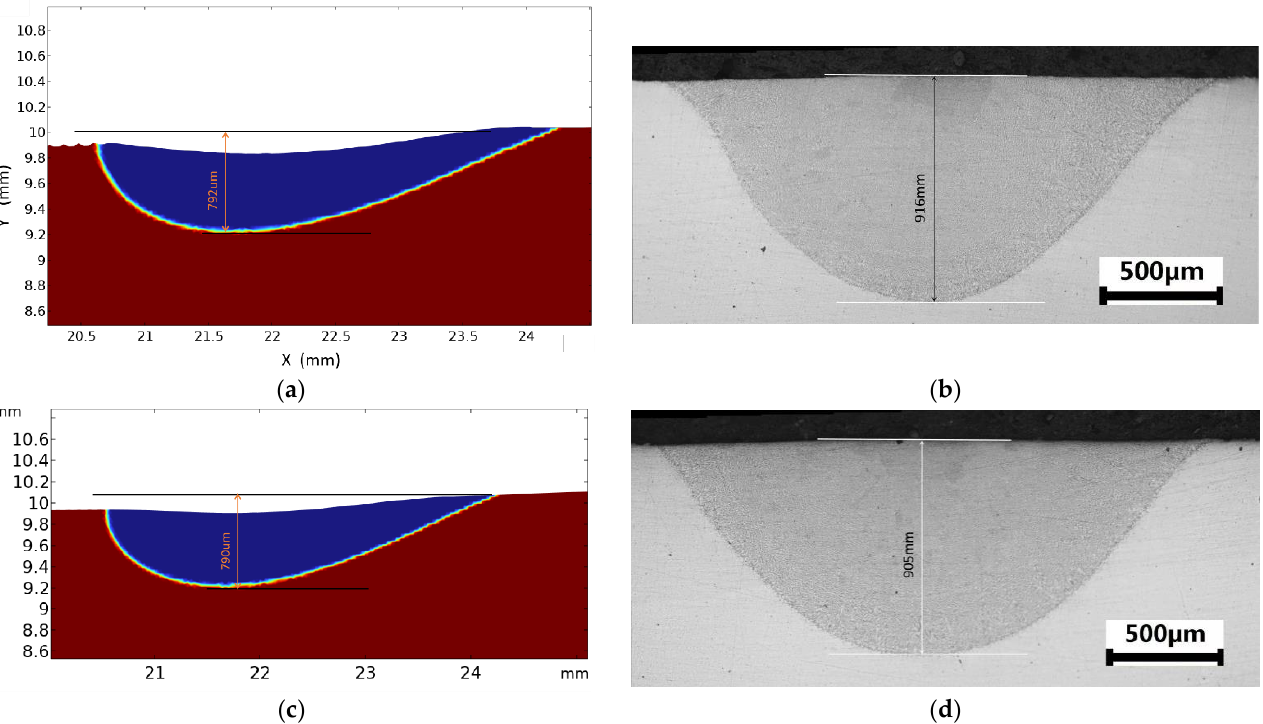
Figure 12. Shape of the molten pool ( a ) at 4.5 s Bz = 0 T, ( b ) actual molten pool shape Bz = 0, ( c ) at 4.5 s Bz = 2.0 T, and ( d ) actual molten pool shape Bz = 2 T.